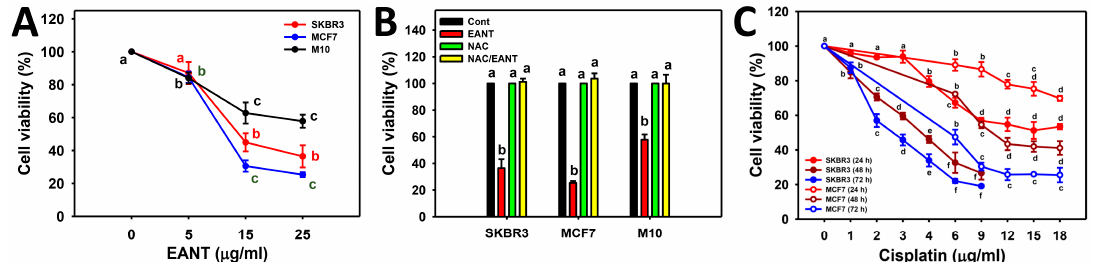
Figure 1. Cell viability following ethyl acetate extract of Nepenthes thorellii x (ventricosa x maxima) (EANT) treatment. ( A ) Cell viability of breast cancer cells (MCF7 and SKBR3) and breast normal cells (M10) treated with 0 (control with DMSO only), 5, 15, and 25 µ g / mL of EANT for 24 h. ( B ) Cell viability of breast cancer cells after NAC pretreatment (2 mM for 1 h) and EANT post-treatment (25 µ g / mL for 24 h), i.e., NAC / EANT. ( C ) Cell viability of breast cancer cells treated with di ff erent concentrations of cisplatin for 24, 48, and 72 h. For each cell line, treatments labeled without the same lower-case letters indicate significant di ff erence. p < 0.05~0.0001. Data, mean ± SD ( n = 3).